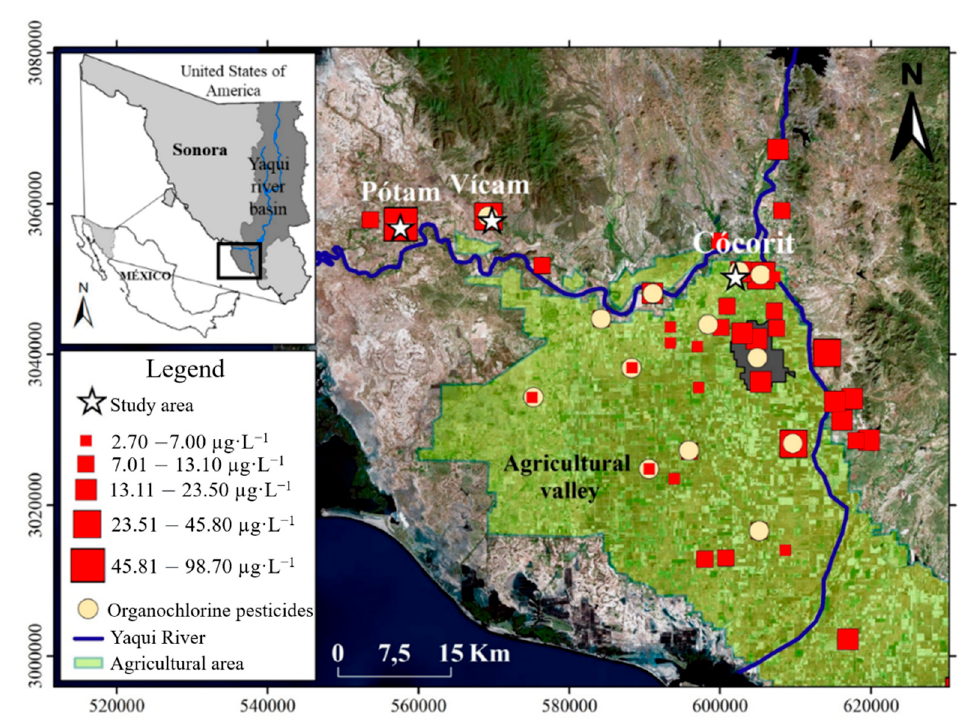
Figure 2. Sample location sites included in the present work. Red boxes indicate arsenic concentrations [24]. Yellow circles represent sampling areas where analysis of organochlorine pesticides have been reported.